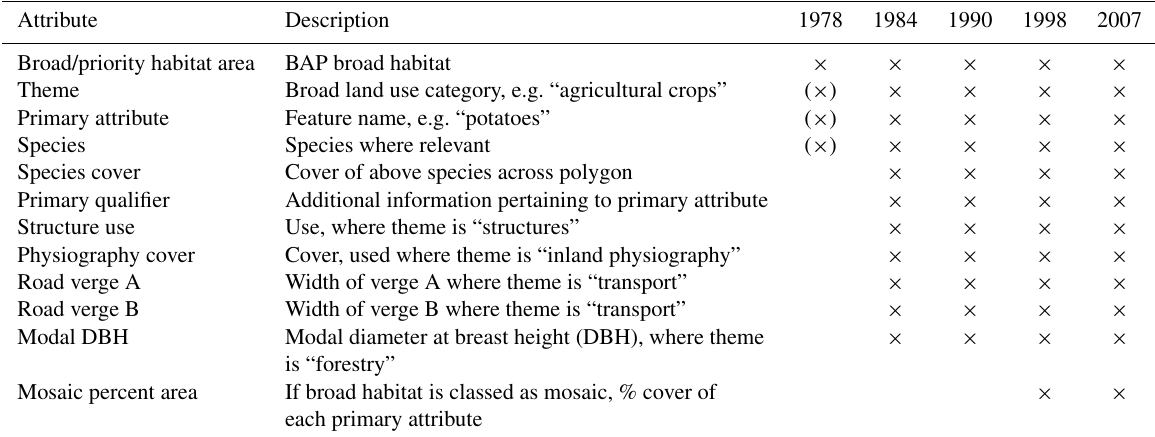
Table 1. Data collected within mapped polygons. Attribute